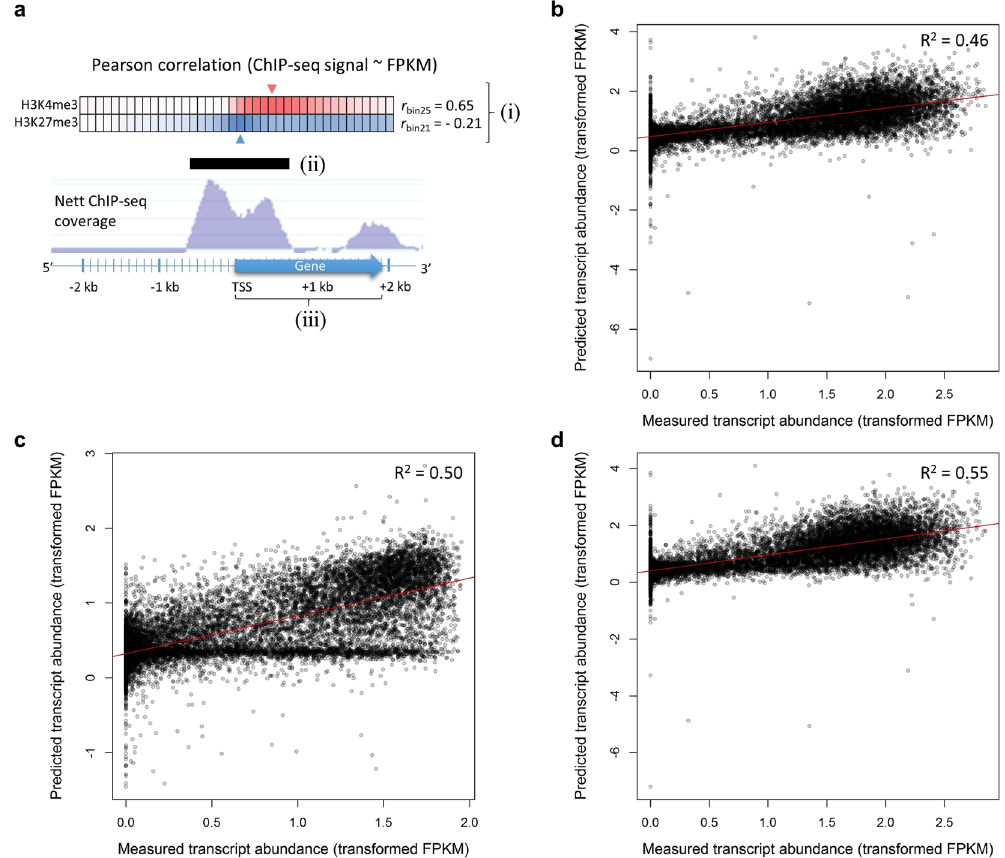
Figure 5. Prediction of steady-state transcript abundance in developing secondary xylem from histone modification ChIP-seq data in E. grandis and Arabidopsis. ( a ) Three ChIP-seq variables were considered for per-gene histone modification enrichment, namely the nett ChIP-seq coverage over one of forty 100 bp bins showing the strongest Pearson correlation with transcript abundance (i), the significant ChIP-seq peak length (bp) (ii), and the nett ChIP-seq coverage across the entire transcribed region (iii). ( b ) Prediction of transcript abundance using a multiple linear regression model trained on E. grandis H3K4me3(bin25) and H3K27me3(bin21) ChIP-seq data. ( c ) Prediction of transcript abundance using a multiple linear regression model trained in Arabidopsis H3K4me3(bin24) and H3K27me3(bin21) ChIP-seq data. ( d ), Prediction of transcript abundance using nine HM ChIP-seq datasets in Arabidopsis 35